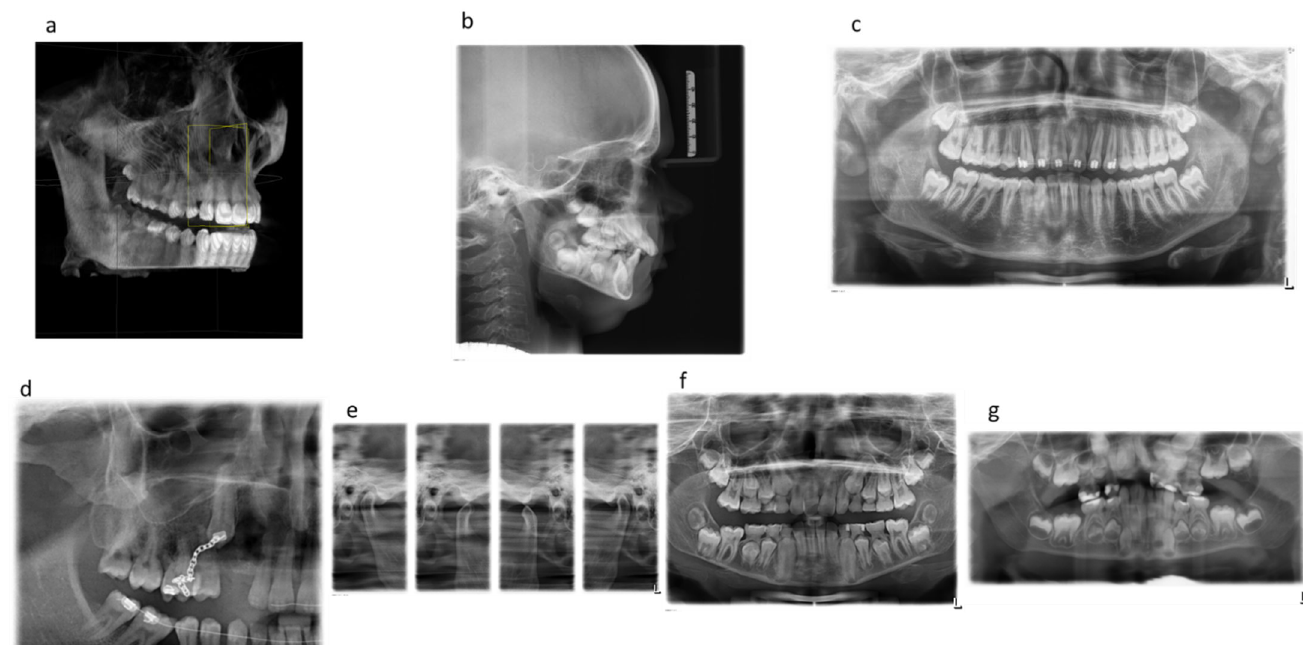
the extraoral X-ray images analyzed: ( a ) CBCT, ( b ) lateral cephalogram, ( c ) OPG standard, ( d ) OPG without TMJ left and half OPG image, ( e ) OPG TMJ program, ( f ) OPG without TMJ right and left,